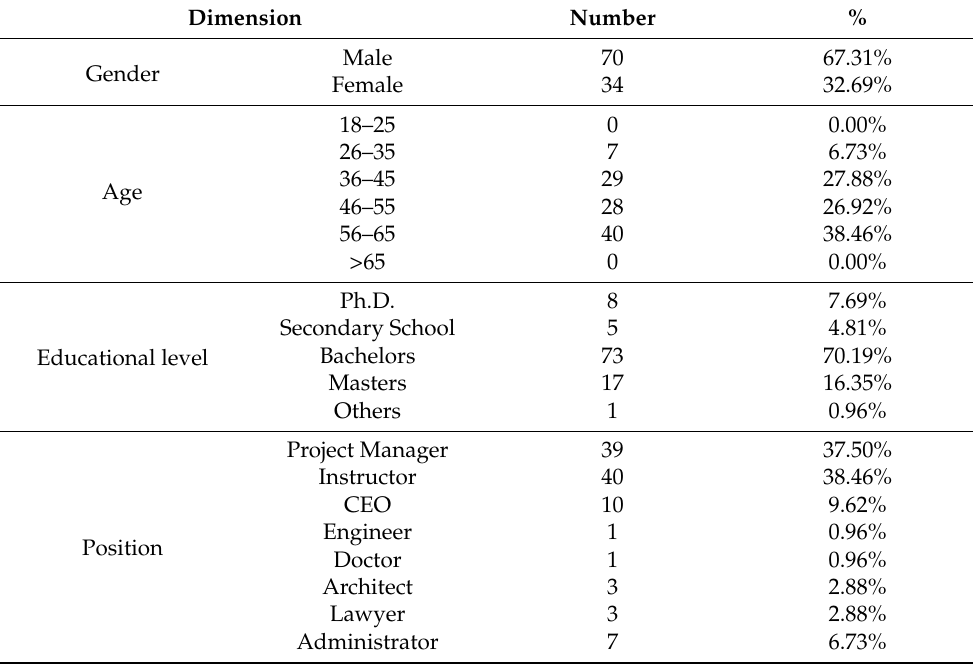
Table 1. Demographic profile of the